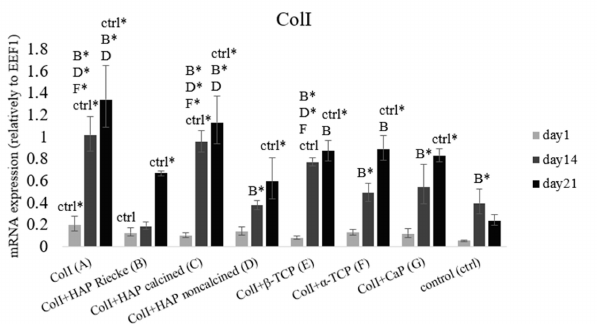
Figure 5. The main extracellular bone protein collagen type I mRNA expression relative to EEF1D. Cells seeded on: Coll ( A ), ColI+HAP Reicke ( B ), ColI+HAP calcined ( C ), ColI+HAP noncalcined ( D ), ColI+ β -TCP ( E ), ColI+ α -TCP ( F ) and ColI+CapolyP ( G ). Negative control group—MSCs on tissue culture plastics. Statistical significance marked with the name of group and asterisk sign for p <